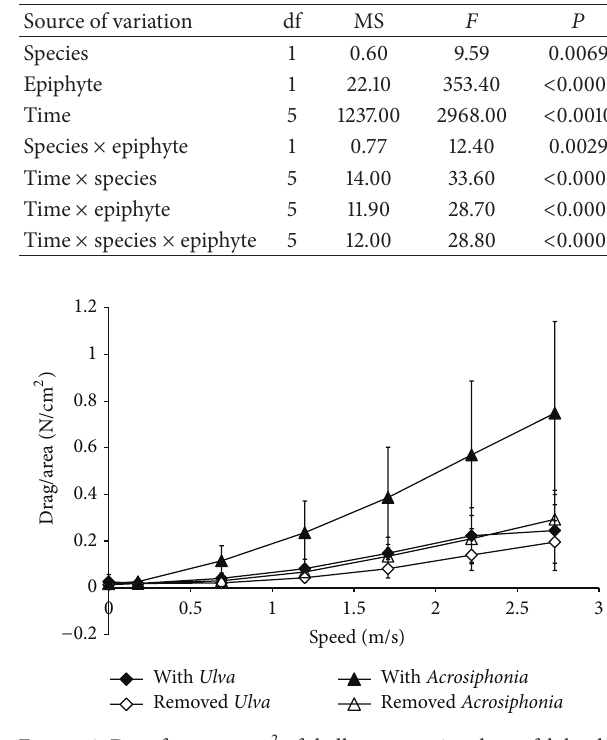
Figure 2: Drag force per cm 2 of shell cross-sectional area felt by the limpet as water velocity was increased. Data are means ± standard